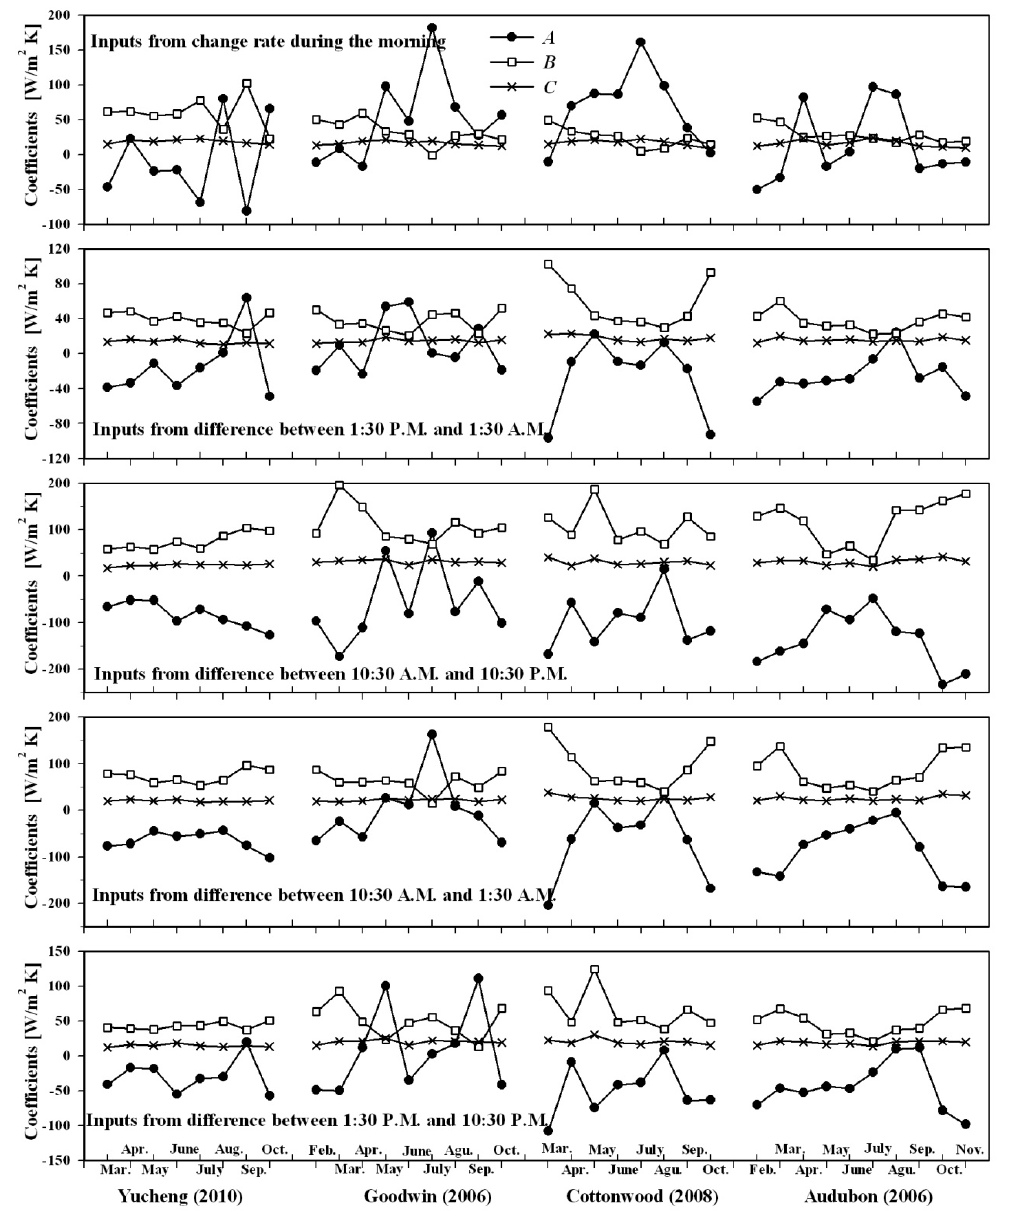
Figure 9. Variations of coefficients A , B , and C in the developed parameterization with atmospheric conditions for five different input